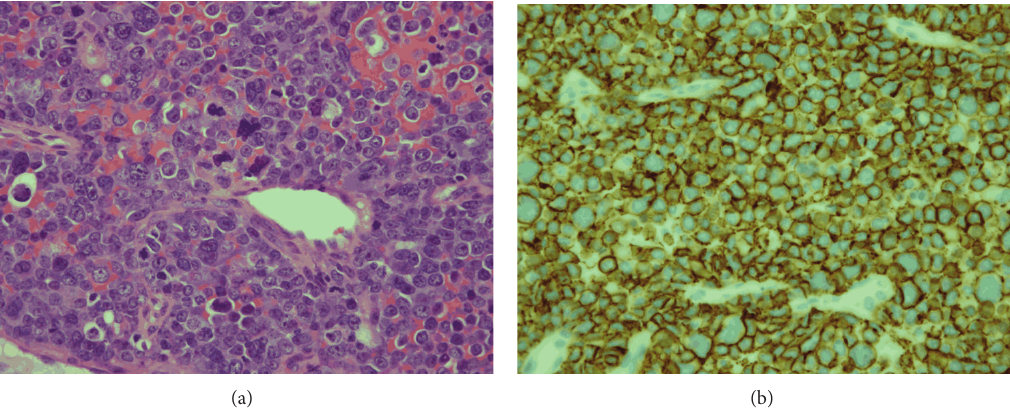
Figure 3: (a) Histopathological image of the biopsied tracheal mass shows an infiltrate of monotonous population of large cells with vesicular nuclei and prominent central nucleoli. Numerous highly anaplastic cells are also seen (H&E, × 40). (b) On immunoperoxidase staining, cells show positive staining for CD 20 confirming malignant B lymphocytes (CD 20, ×